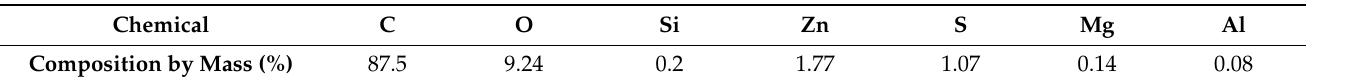
Figure 2. Crumb rubber used. Table 3. Chemical Composition of CR. Reprinted with permission from Ref. [46] Copyright 2023 Elsevier